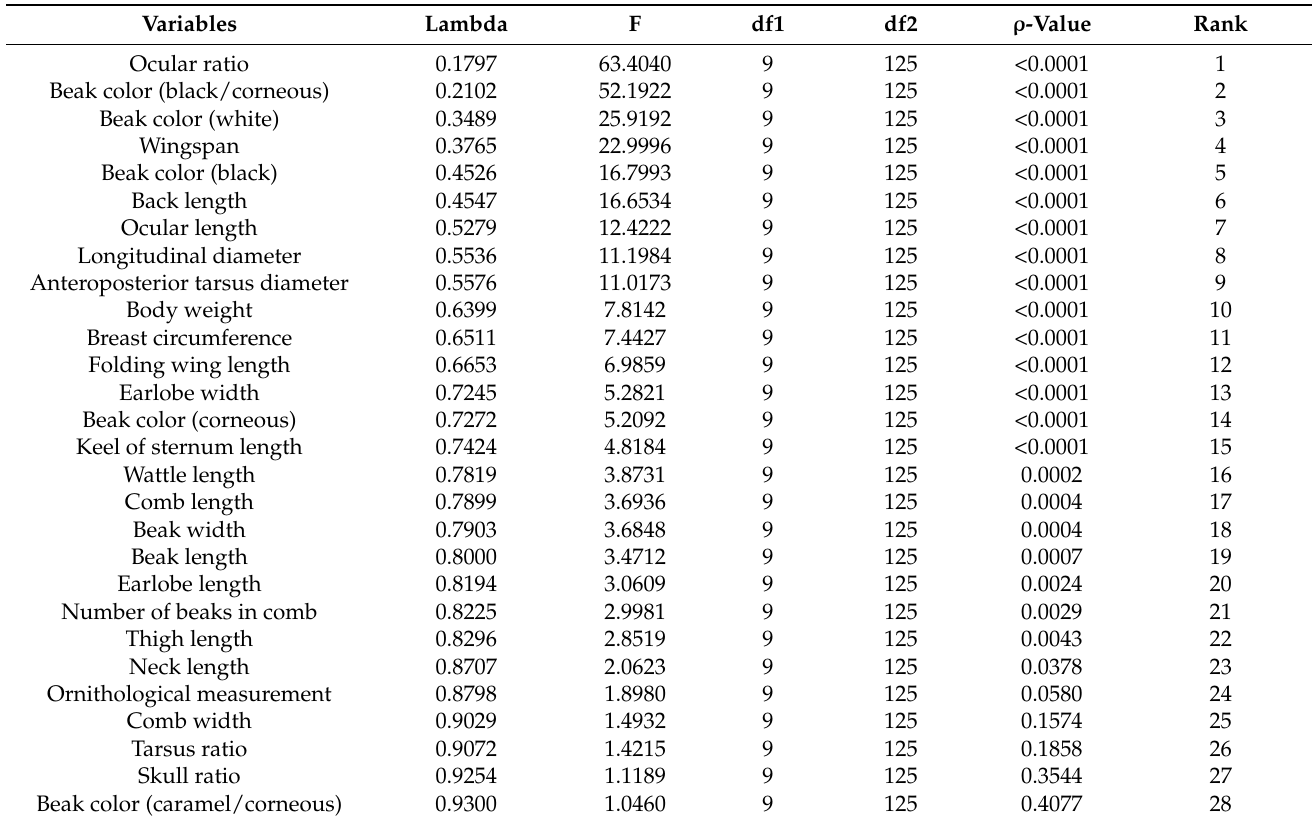
Table 7. Results for the tests of equality of group means test for difference in the means across groups once redundant variables were removed in the male